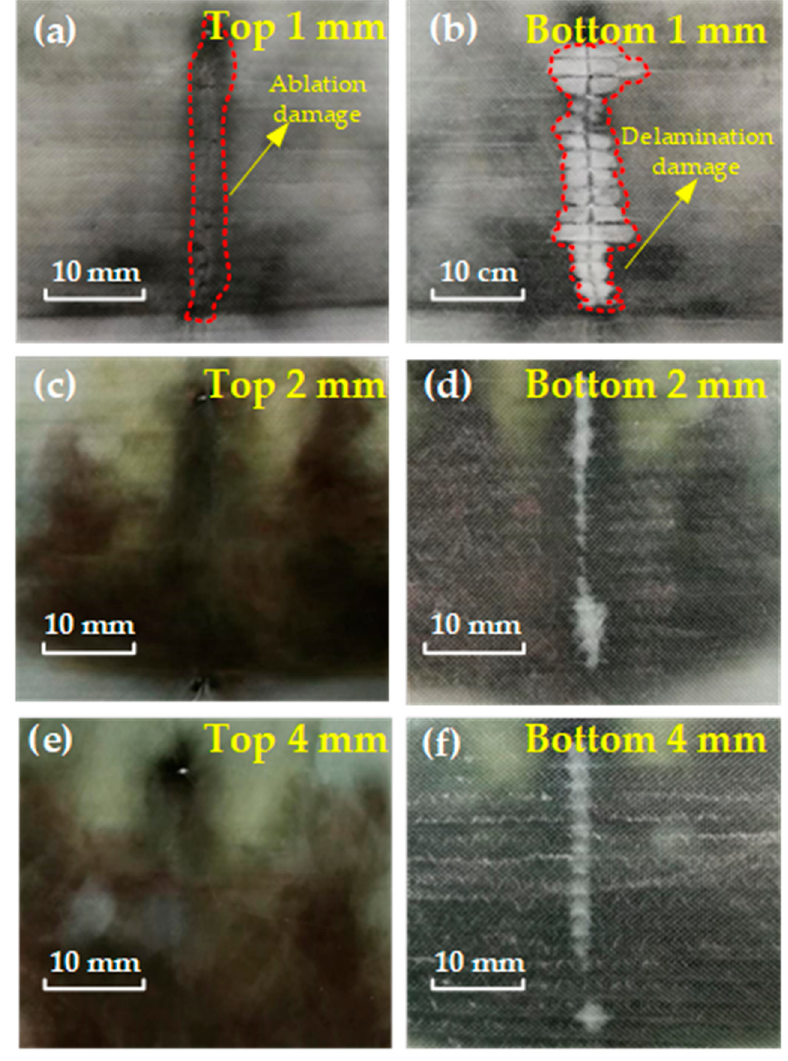
Figure 10. Damage status of GFRC laminates with different thicknesses under lightning current component A with an amplitude of 40 kA.